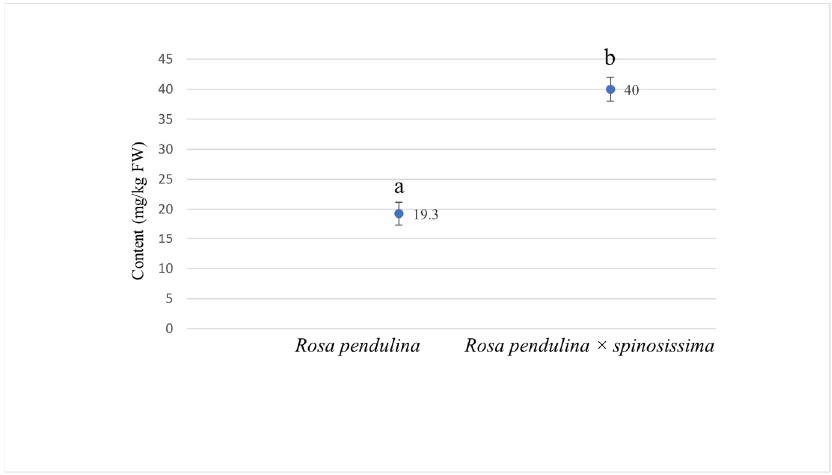
Figure 3. Average contents ± standard deviations (mg/kg FW) of cyanidin-3-glucoside in hips of R. pendulina and the hybrid genotype R. pendulina × spinosissima in the region of Western Slovenia in 2020. Different letters indicate statistical differences between the two genotypes.